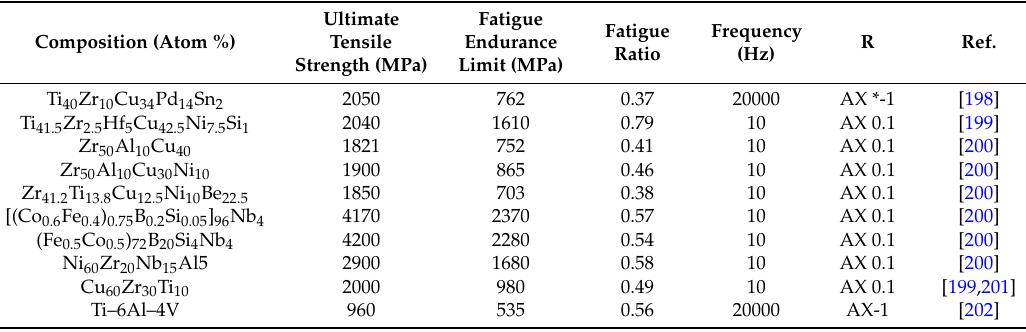
Table 6. Fatigue-endurance limits and fatigue ratios of various BMGs